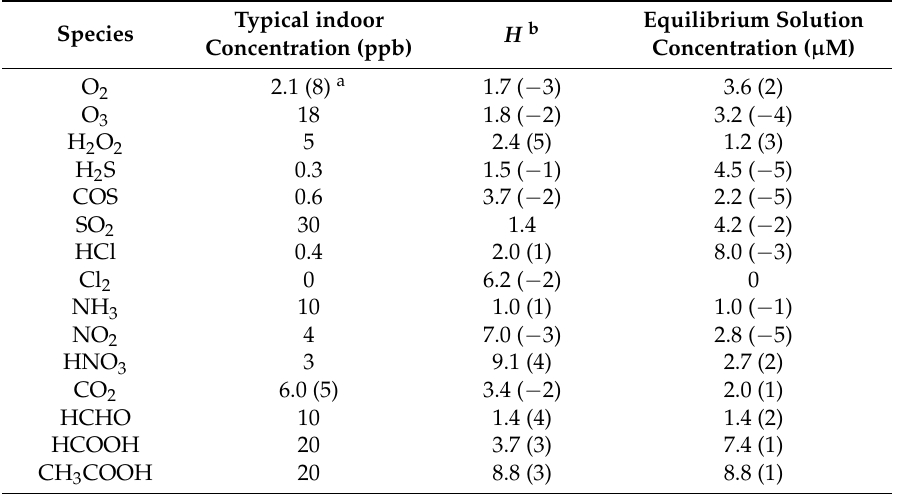
Table 1. Important corrosive gases in indoor environments [1,2]. Reproduced from [1] by permission of The Electrochemical